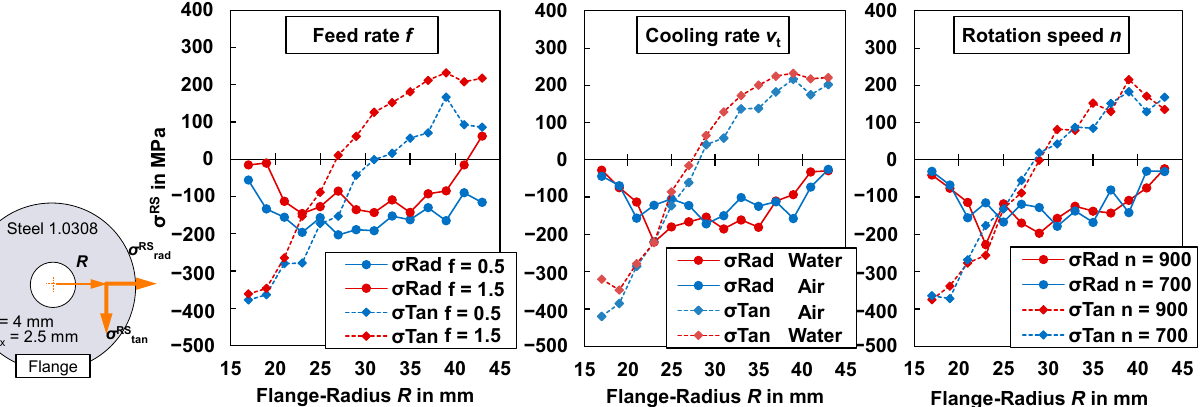
Figure 5. Near-surface residual stress distributions in steel flanges formed by the friction spinning of tubes (1.0308). Residual stresses measured by the XRD cos α -method on the upper flange side. Values are averaged over the high and low setting of each process parameter.